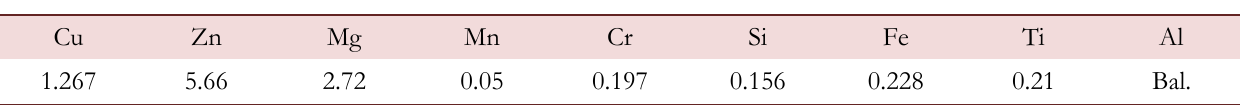
Table 1: Chemical composition of 7075 aluminium alloy.